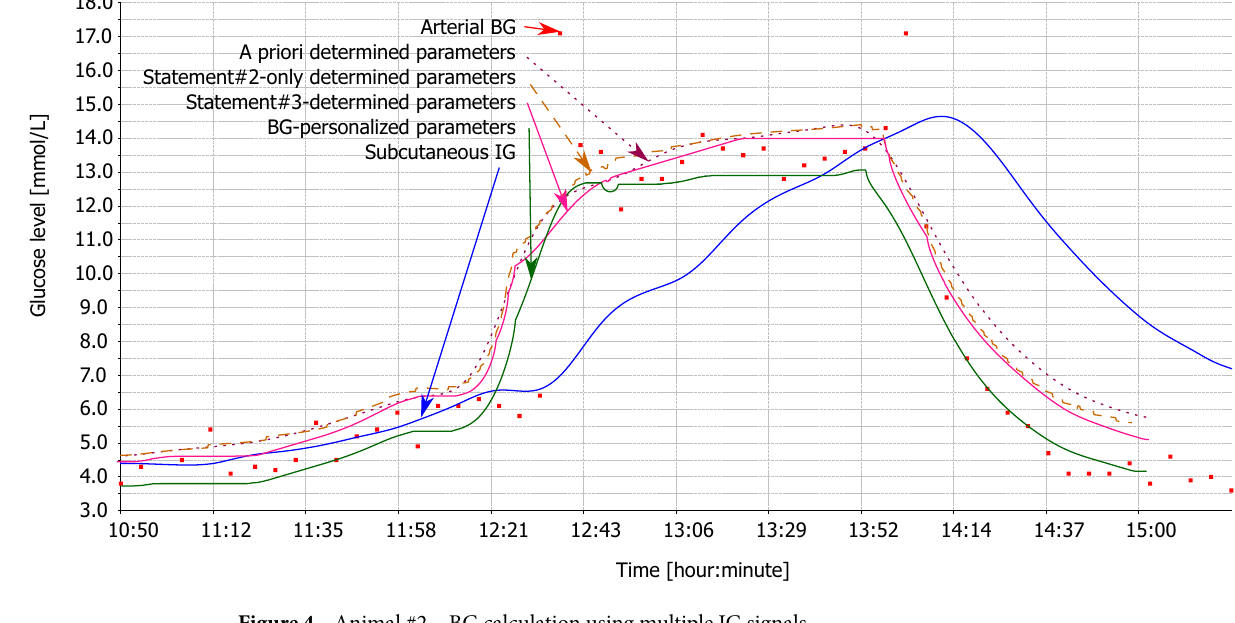
Figure 4. Animal #2 – BG calculation using multiple IG signals.